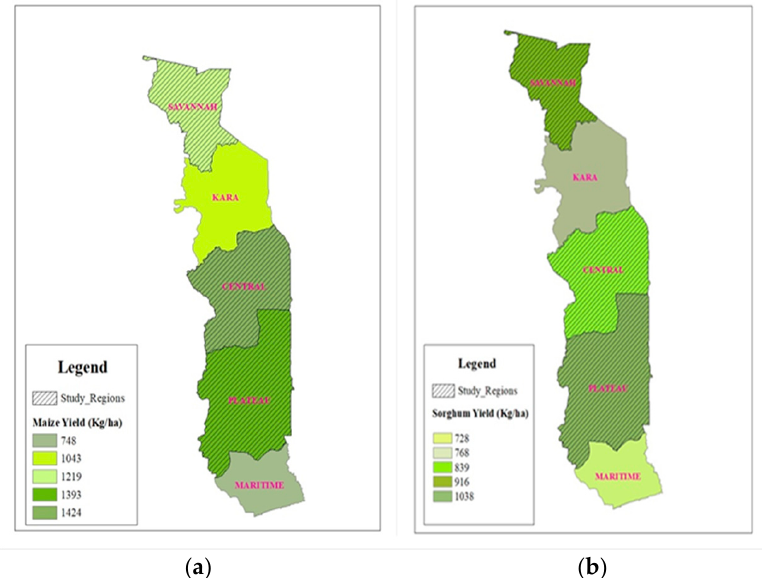
Figure 2. Average yields for maize ( a ) and sorghum ( b ) in Togo’s five administrative regions (1990–2019). Table 1. Growth stages of maize/sorghum in the Plateau, Central, and Savannah